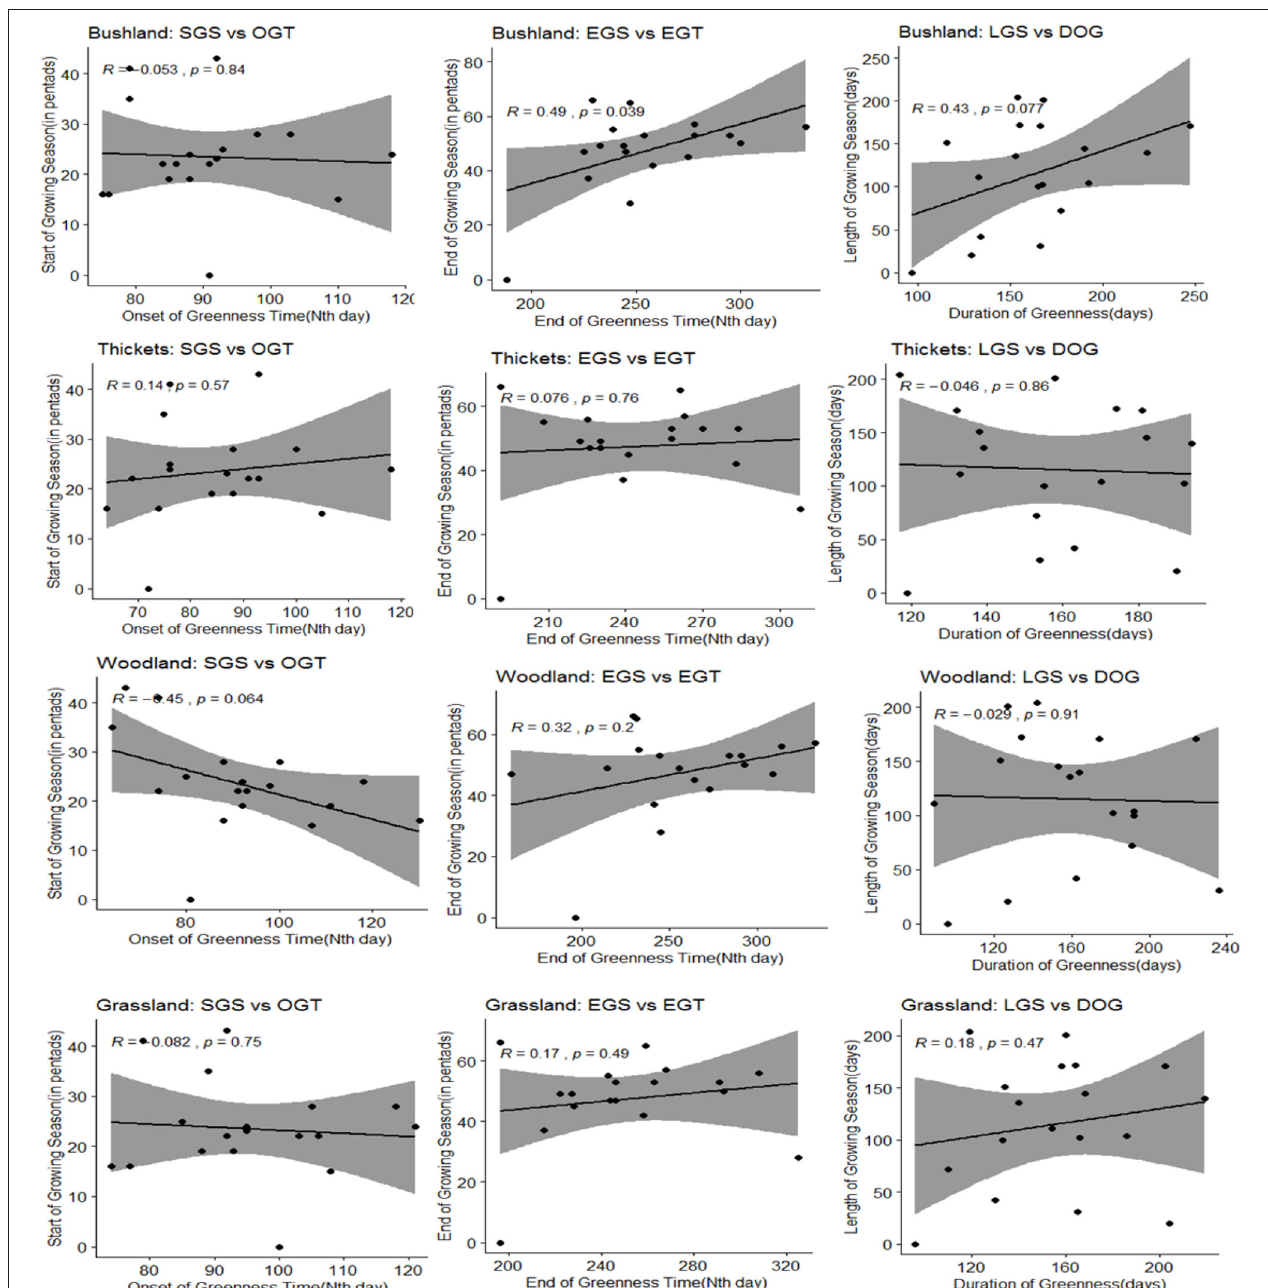
FIGURE 8 | Relationship between rainfall SGS, EGS and LGS and vegetation phenological parameters.